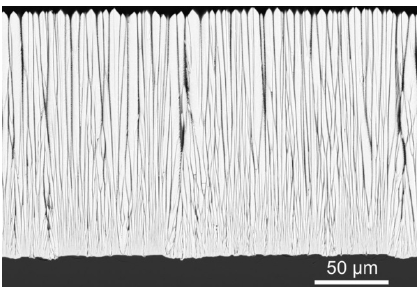
Cross-sectional microstructure of EB-PVD coatings. Reproduced with permission from Ref.